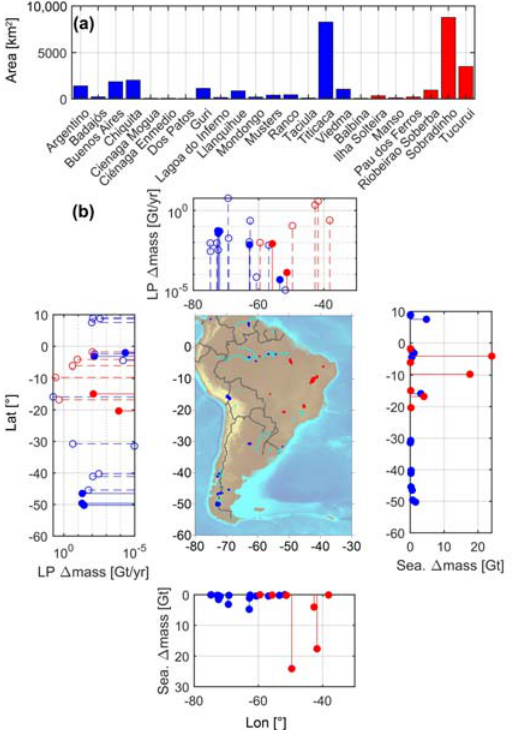
Figure 2. ( a ) Block-diagram showing the areal extents of the largest lakes (blue) and reservoirs (red) in South America. ( b ) Seasonal and long-period (LP) mass changes for selected lakes and reservoirs in South America. LP changes are given in logarithmic scale. The map shows the position of the various lakes: in red, artificial lakes, and in blue, natural lakes; the plots on the right and at the top show, as a function of longitude and latitude, the LP mass variations of the lakes (blue) and reser ‐ voirs (red). The plots are in log scale; the dashed lines indicate negative trends (mass loss), and the solid lines positive trends (mass increase). The plots on the bottom and left similarly report the yearly seasonal mass change (half peak2peak). Color code as above. Large lakes include Titicaca (>8000 km 2 ) and the two reservoirs Tucurui and Itaparica (also known as Sobradinho), the latter being the largest lake in South America.